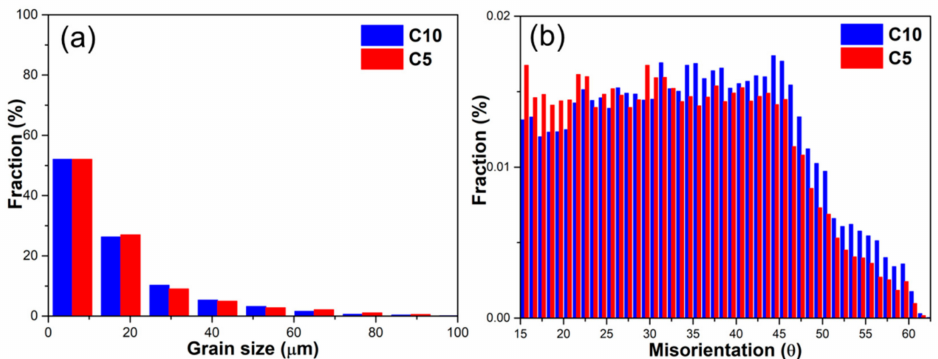
Figure 5. ( a ) Grain size and ( b ) HAGB distributions in y–z plane of as-built Cr components with long scan length (C10) and short scan length